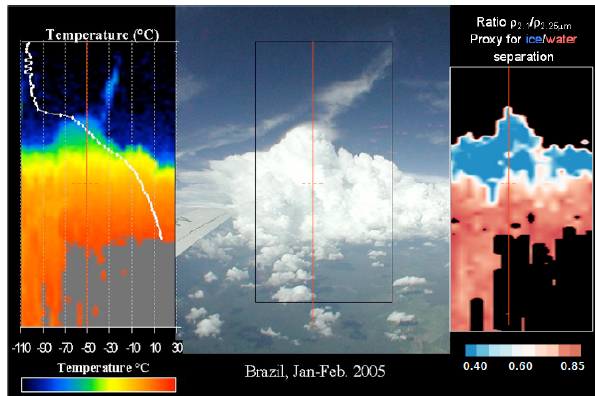
Fig. 6. Cloud side measurements performed with the cloud scanner prototype. The left panel shows the brightness temperature pro- file, the center panel shows the actual picture of the cloud being observed, and the right panel shows an image of the ratio of re- flectances at 2.10/2.25µm, which represents the separation between ice and water particles in the cloud. The white line and dots on the left panel represents the temperature profile. The same solid red line is shown on the center and right panels of the figure. The red dashed horizontal line represents the zero Celsius mark where also the mixed phase starts on the right hand side